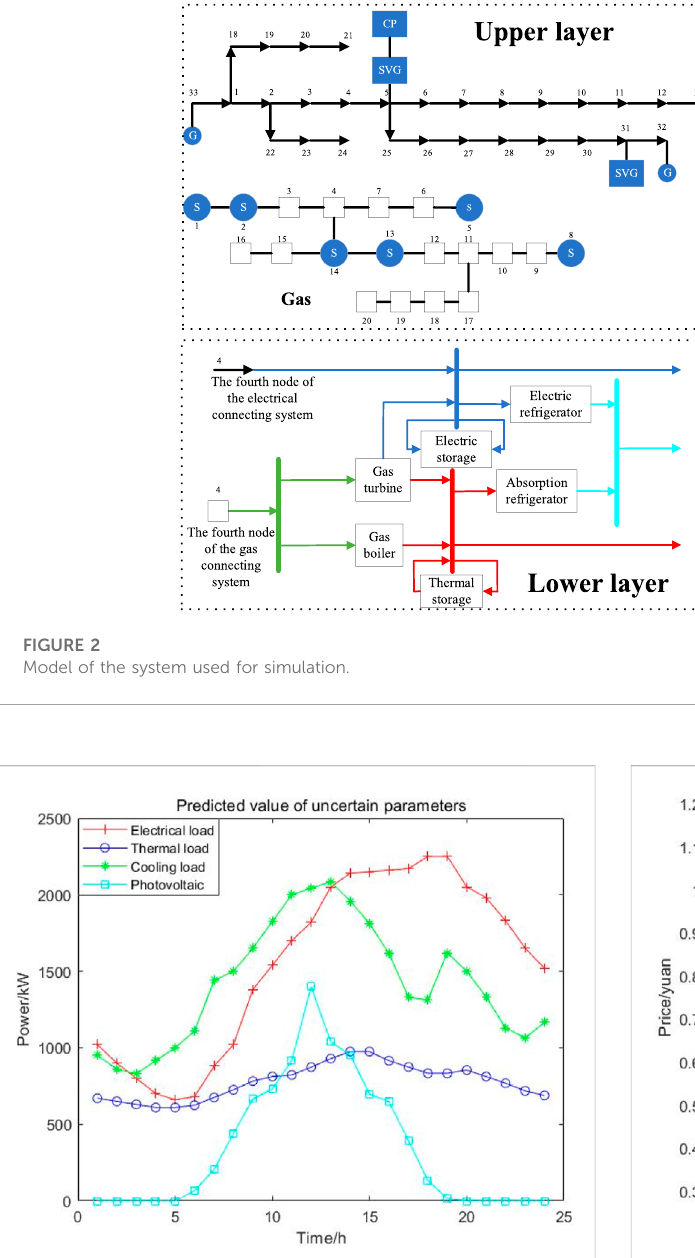
FIGURE 3 Predicted values of various loads and PV.